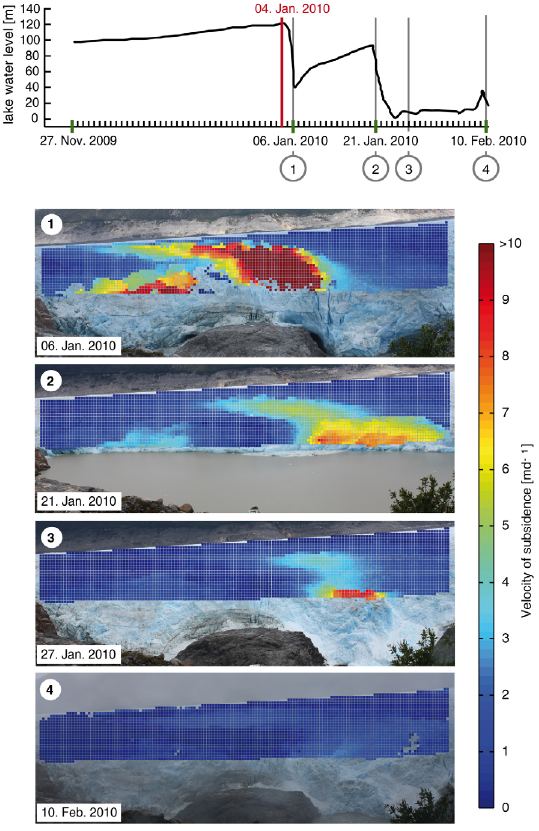
Figure 8. Daily subsidence rates